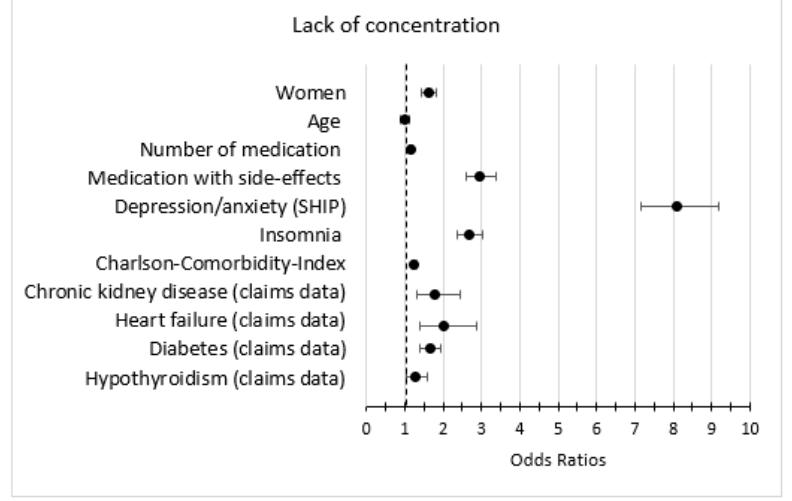
Figure 4. Bivariate logistic regression models (anemia + second variable) with the outcome lack of energy; only the estimates (odds ratios and 95% confidence intervals) of the second variable is shown (weighted) .